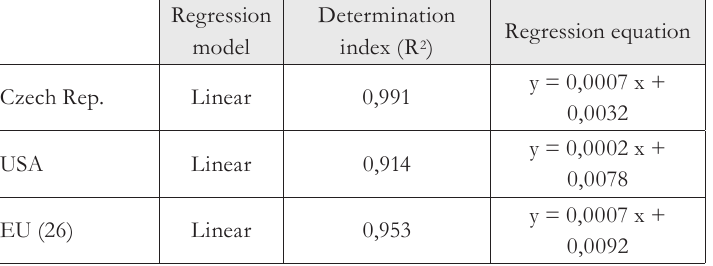
Tab. 5 - Results of regression analysis of the values of the time series of population and tertiary education graduates. Source: (Eurostat, 2013a), (World Bank, 2011), own